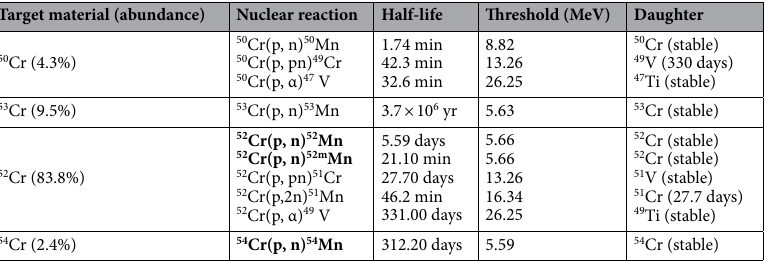
Target material